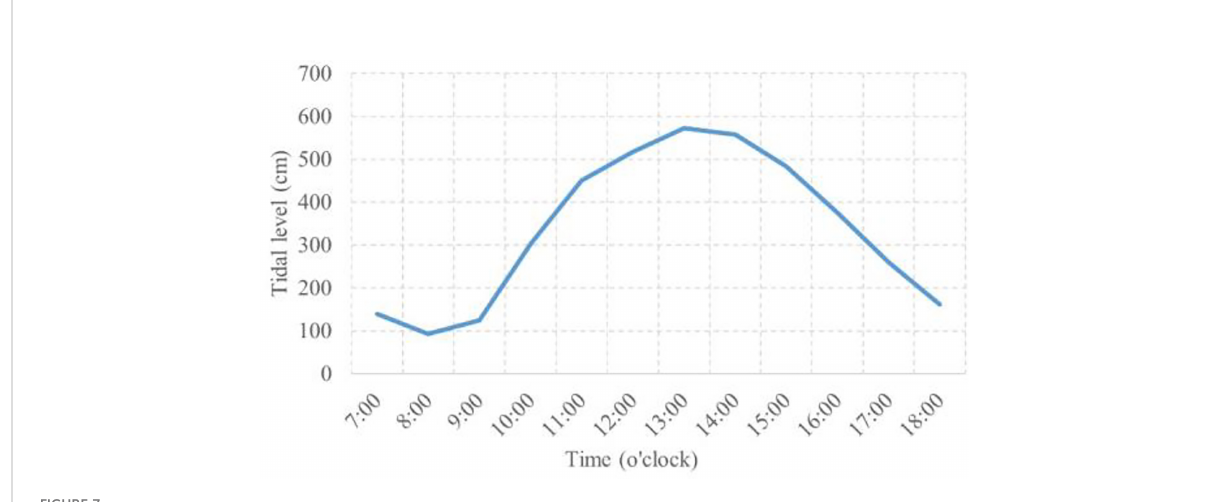
FIGURE 7 Tidal changes in the study area (July 23,